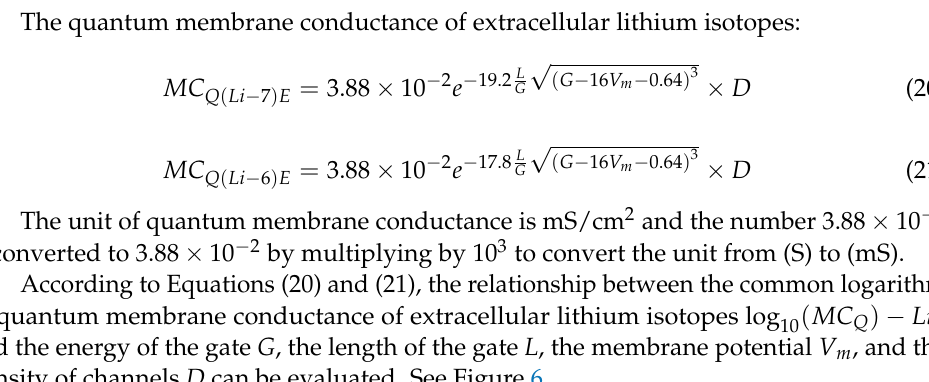
( C ) − Li I and the energy Q 10 ( C ) − Li = 5 J and I and the length of the gate L by setting G Q 10